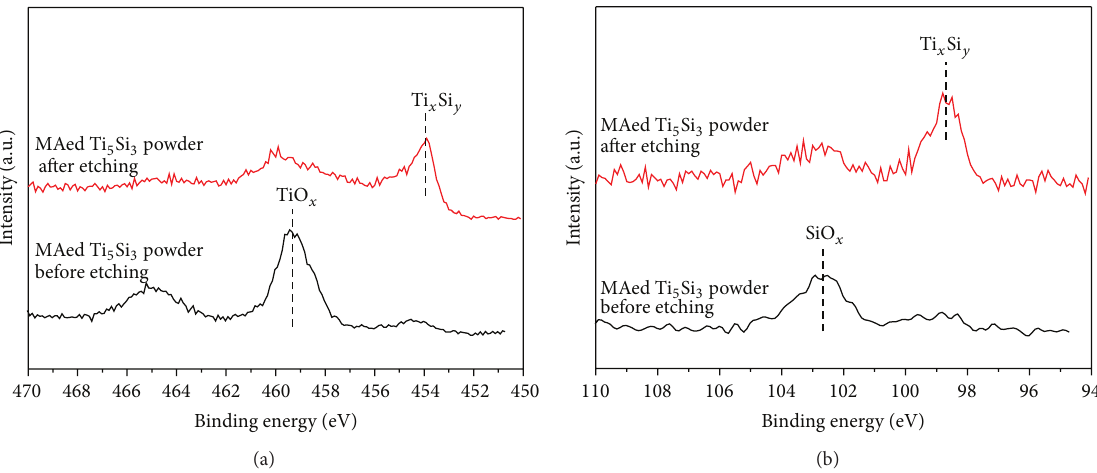
Figure 3: XPS narrow scan spectra of the (a) Ti 2p and (b) Si 2p region of MAed Ti 5 Si 3 powder before and after light Ar + etching for 5